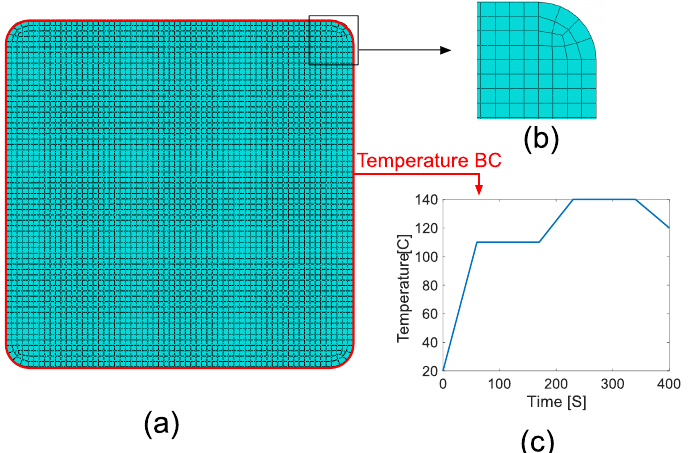
Figure 4. ( a ) 2D modeling domain, ( b ) a closer look at the mesh structure, ( c ) temperature profile defined on the boundary (the outer surfaces of the